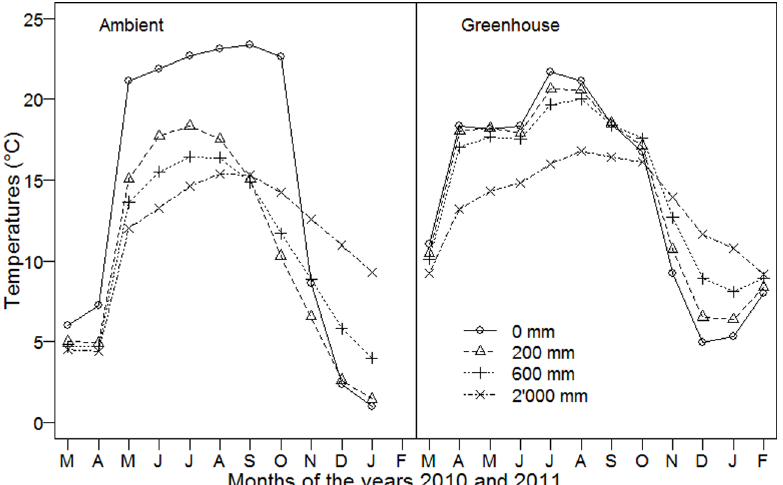
Fig. 2. Mean monthly temperatures outside (ambient) and inside greenhouse in Simikot, Humla, at 3000m a.s.l. at different soil depths (0 – 2000 mm below ground), all © A.